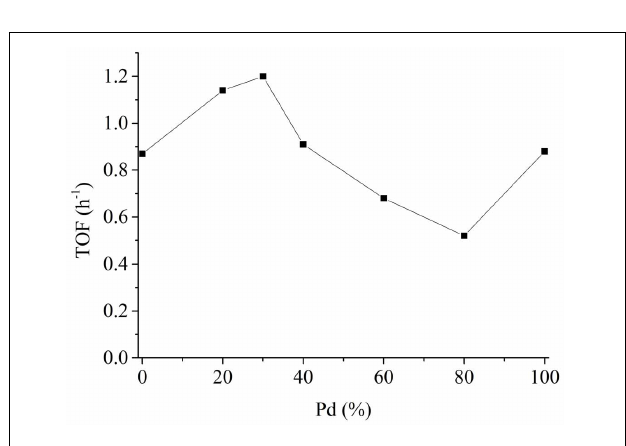
FIGURE 2 | TOF of NiPd NPs as a function of Pd content. Reaction conditions: 0.012mol NaHCO 3 , 1.2mmol catalyst, 24mmol PVP, 40ml H 2 O, 20 bar H 2 , 80 ◦ C,